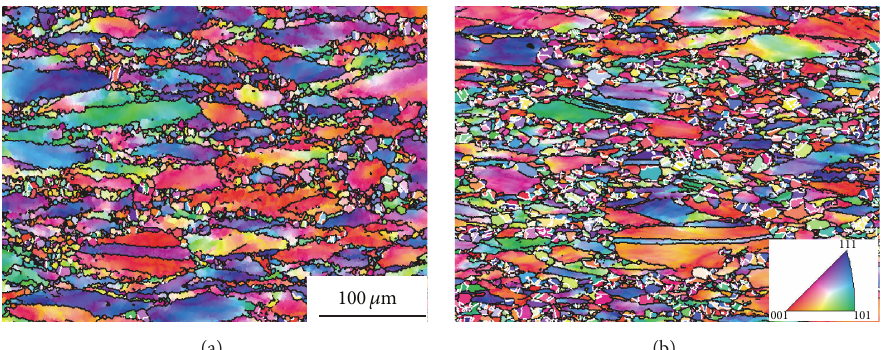
Figure 7: Microstructure of 316LN steels with different N content deformed at 1273 K and 0.1 s −1 : (a) 08N; (b) 17N (the vertical direction is compression direction).